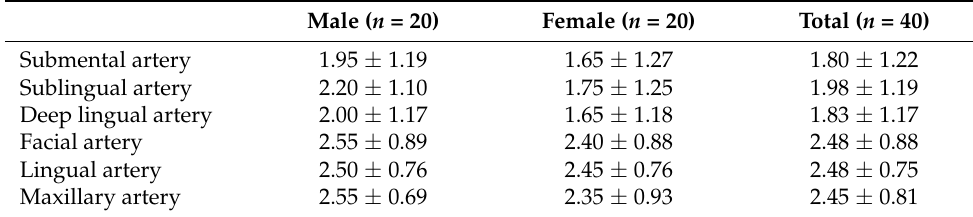
Table 2. Conspicuity in the visualization.